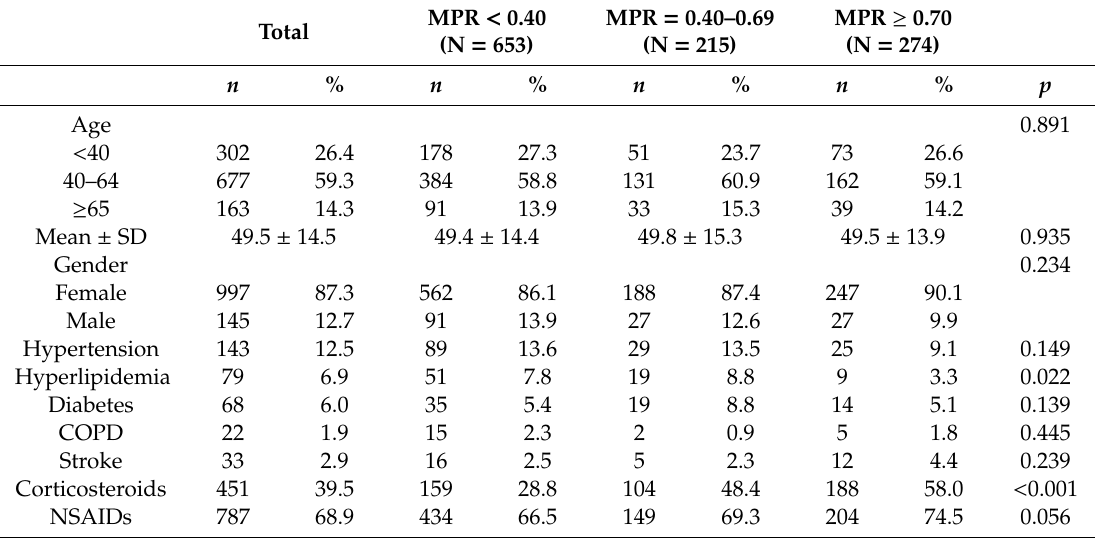
Table 1. Clinical characteristics of the three-medication possession ratio (MPR)